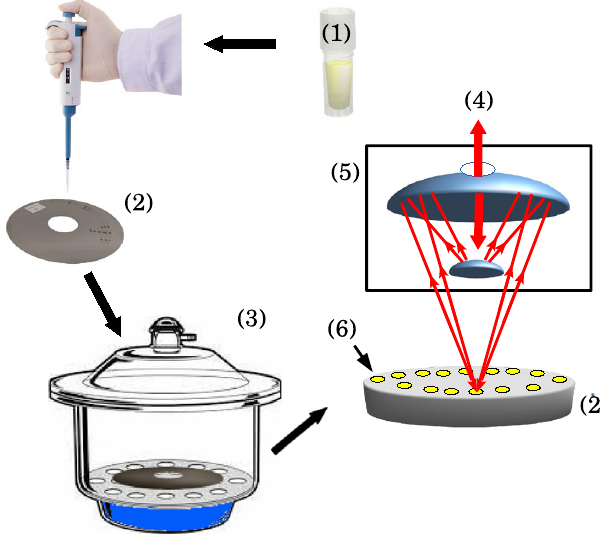
Figure 1. Scheme for micro-FTIR reflectance measurements for human serum. One µL of diluted (1 : 3 in ultra-pure water) serum sample solution (1) was transferred to a circular platinum sample holder (2). Then the sample holder was installed in a desiccator with saturated solution of NaCl (3) which controls the relative moisture in 80%. The drying time was 10 min. After this period the sample holder was installed on the FTIR reflectance accessory of the micro-FTIR spectrometer. The IR beam (4) passing through the IR 60 × magnification Cassegrain lens (5) focuses the light on a given sample (6). The reflected light is collected by the same lens and analyzed by the